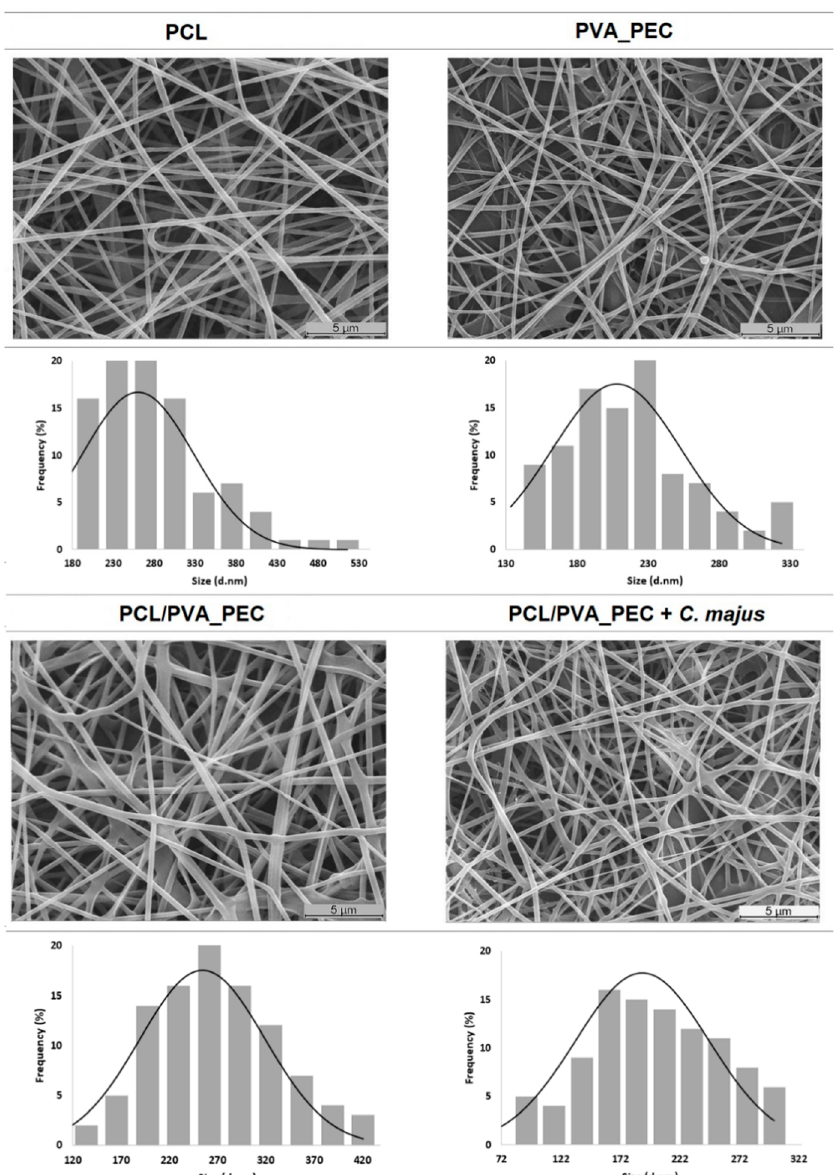
Figure 2. Nanofiber morphology and fiber size distribution of raw electrospun PCL nanofibers, PVA_PEC blend, and both the plain and the C. majus -loaded electrospun PCL/PVA_PEC nanofibrous meshes.